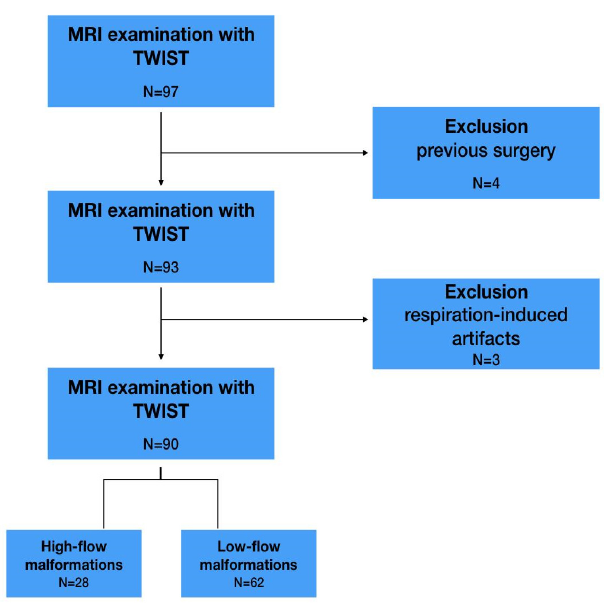
Figure 1. Flow chart of study identification, inclusion and exclusion criteria. MRI—magnetic resonance imaging, TWIST—time-resolved magnetic resonance angiography with interleaved stochastic trajectories.